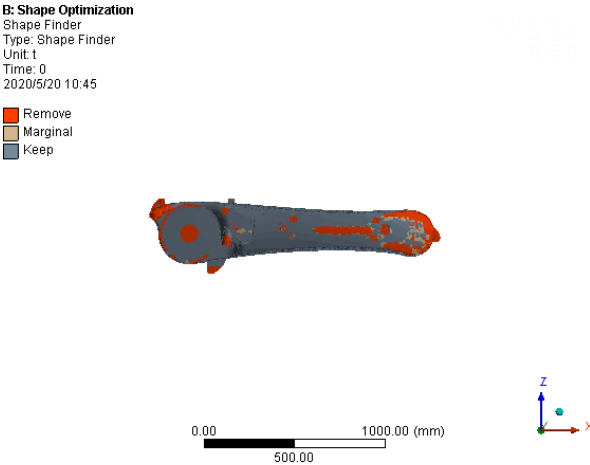
Figure 10. Topology optimization cloud